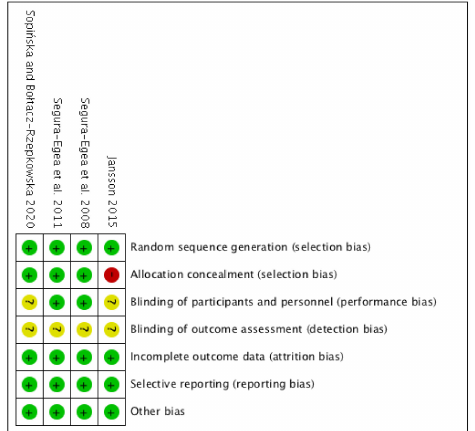
Figure 5. Risk of bias summary of studies included according to the Cochrane Collaboration’s tool for assessing risk of bias. + Low risk of bias. − High risk of bias. ? Unclear risk of